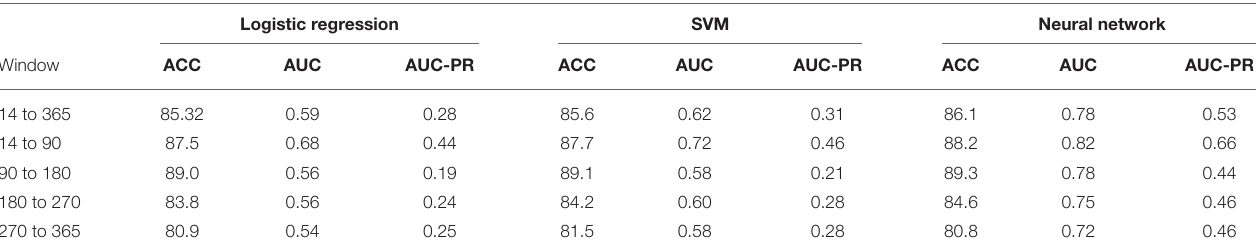
TABLE 5 | Effect of splitting the prediction period into windows based on clinical insight. Logistic regression SVM Neural network Window ACC AUC AUC-PR